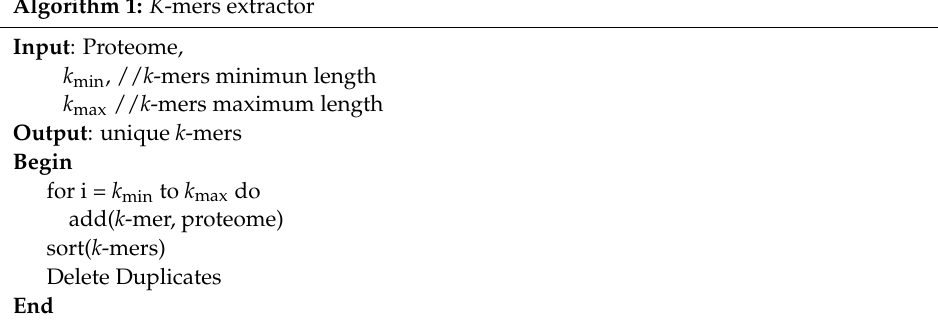
Algorithm 1: K -mers